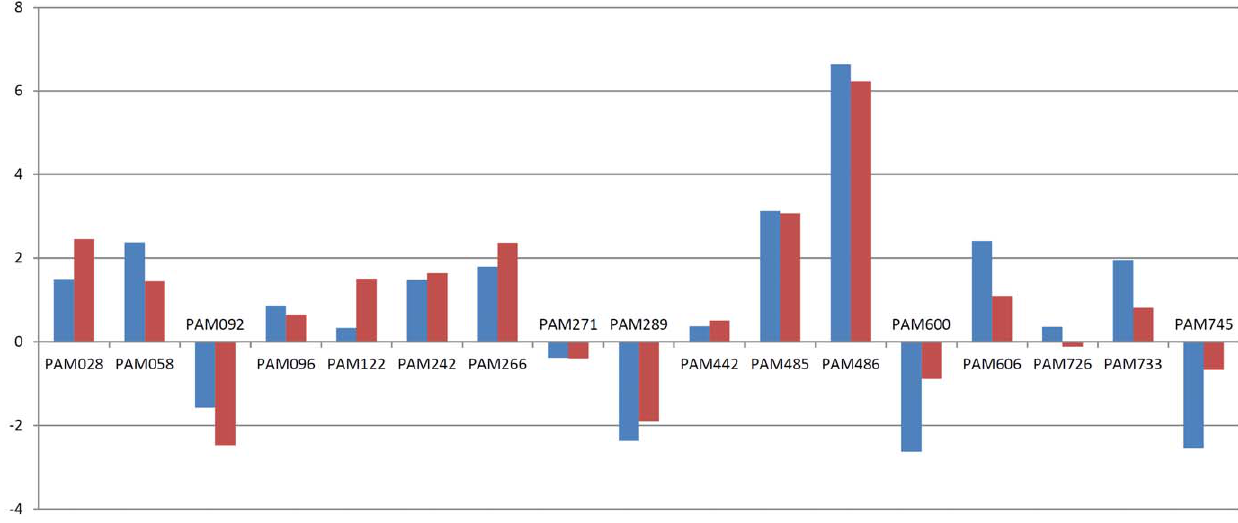
Figure 5. Comparison of gene expression between microarray (red) and real-time quantitative reverse transcription polymerase chain reaction (blue). Log ratio of signal in plant per signal in insect were indicated for PAM028 ( ibpA ; molecular chaperone), PAM058 ( mscL ; mechanosensitive channel), PAM242 ( himA ; bacterial nucleoid DNA-binding protein), PAM266 (hypothetical protein), PAM271 (hypothetical protein), PAM289 (membrane protein), PAM485 (hypothetical protein), PAM486 (secreted protein), PAM600 ( acoA ; thiamine pyrophosphate- dependent dehydrogenase), PAM606 (hypothetical protein), PAM726 ( ssb ; single-stranded DNA-binding protein) and PAM745 ( thrS ; threonyl-tRNA synthetase).